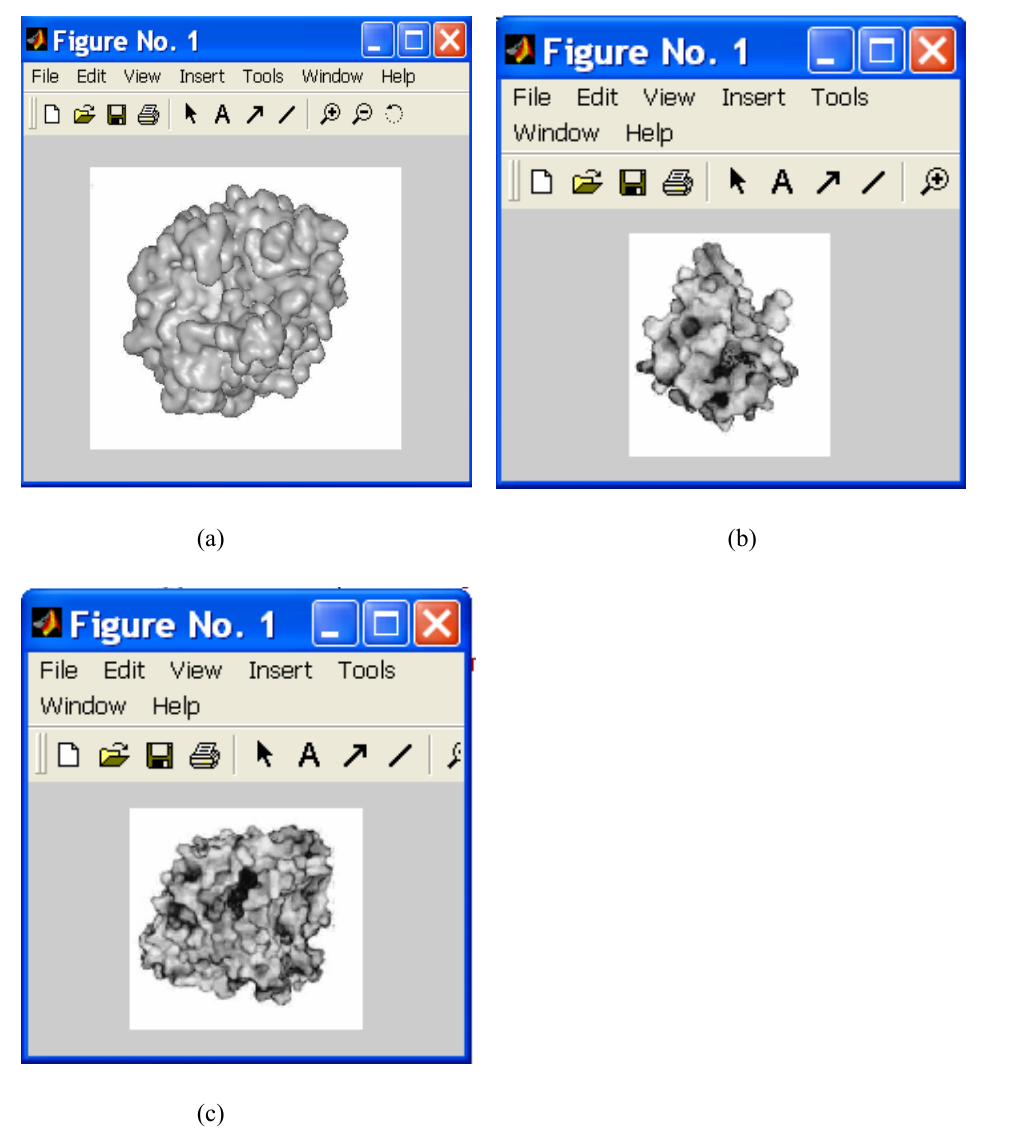
Figure 2: The surface of (a) CRAMBIN (b) Fleix and (C) Dihydropholate reductase generated by our